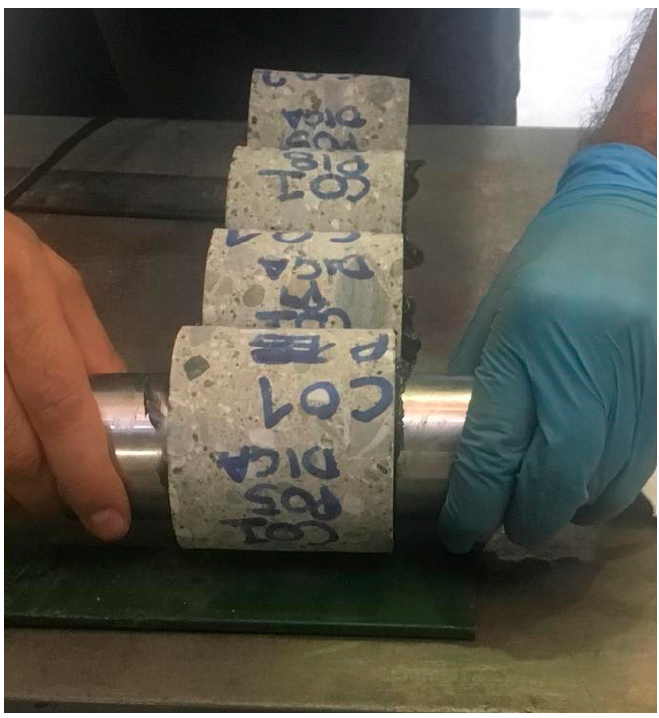
Figure 10. Direct measurement of ultrasonic velocity on single concrete samples.